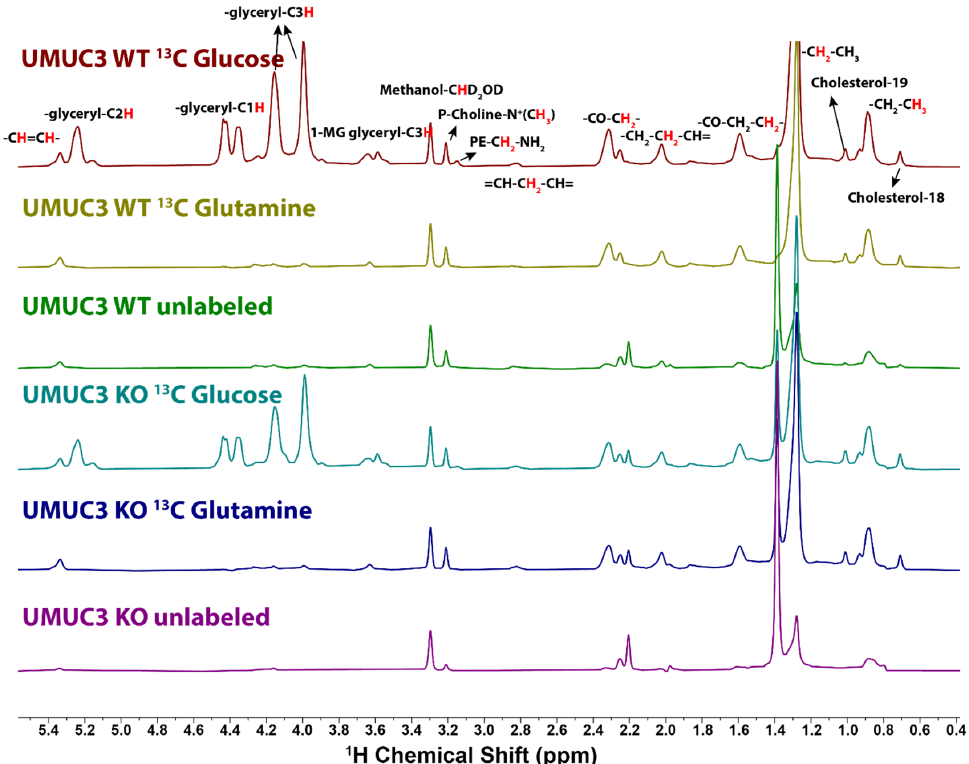
Figure 4. 1D HSQC spectra of the lipid extracts from UMUC3 cells grown in the presence of [U- 13 C]-glucose, [U- 13 C]- glutamine and unlabeled glucose. UMUC3 cells were grown and extracted, then prepared for NMR as described in the Methods section. The HSQC acquisition parameters were as described in Figure 3.